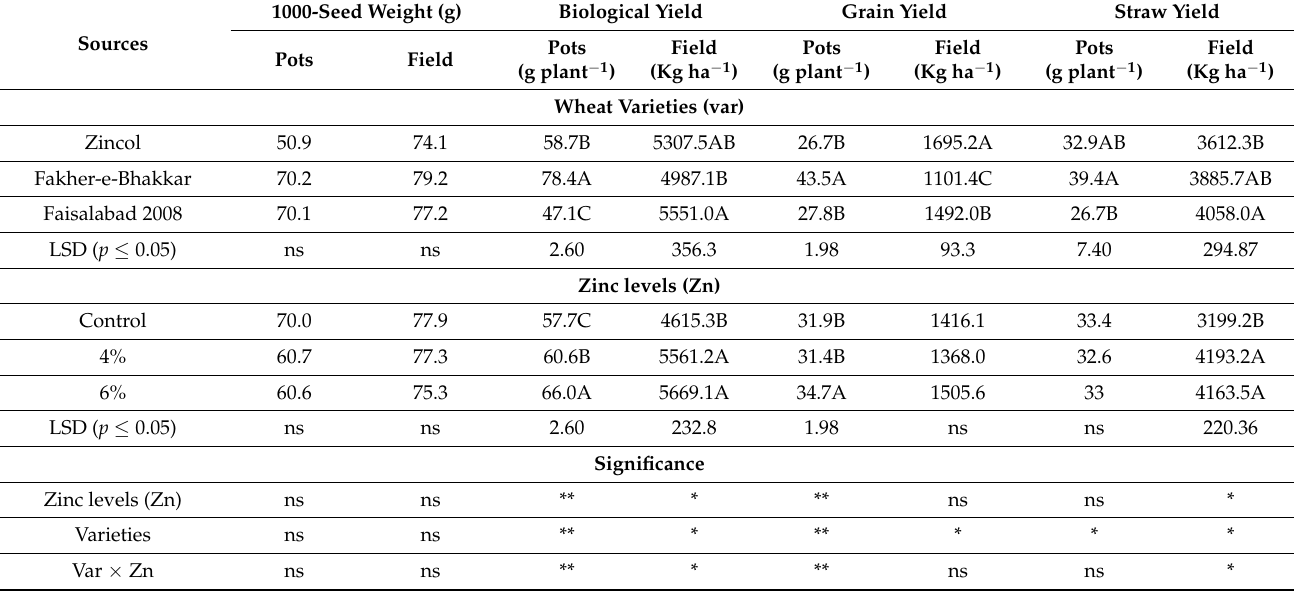
Table 3. Yield and yield related traits as affected by different foliar applied zinc and wheat varieties grown under controlled